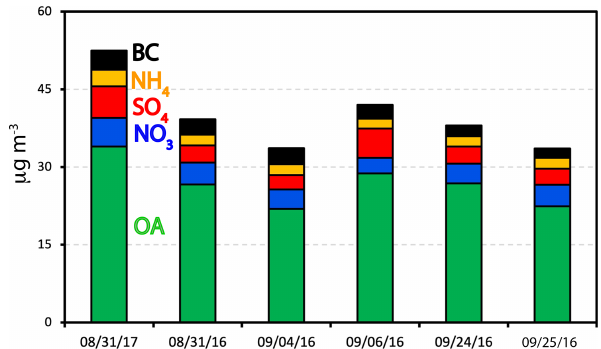
Figure 5. Distribution of the bulk chemical species masses for each flight for 5s samples with OA > 20µgm − 3